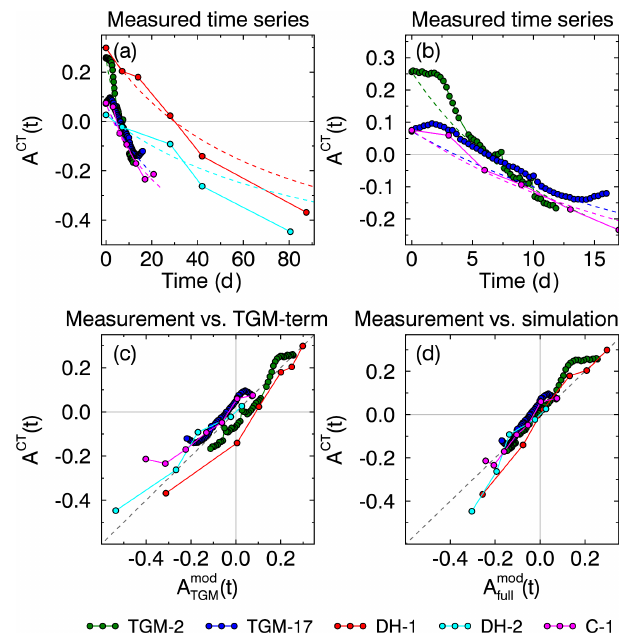
Figure 5. (a) Anisotropy time series A CT (t) of the laboratory experiments from Table 1. Dashed lines indicate modeled re- sults. (b) Zoom into the first 15d after the start of the experi- ment. (c) When ignoring the lower threshold A min and with α 1 = 1 . 0m 2 kg − 1 the simulated data already agree well with CT data. (d) With a lower threshold A min = − 0 . 7 and with α 1 = 1 . 01m 2 kg − 1 , the agreement of model and measurements indicates that the growth of vertical structures is proportional to the water vapor